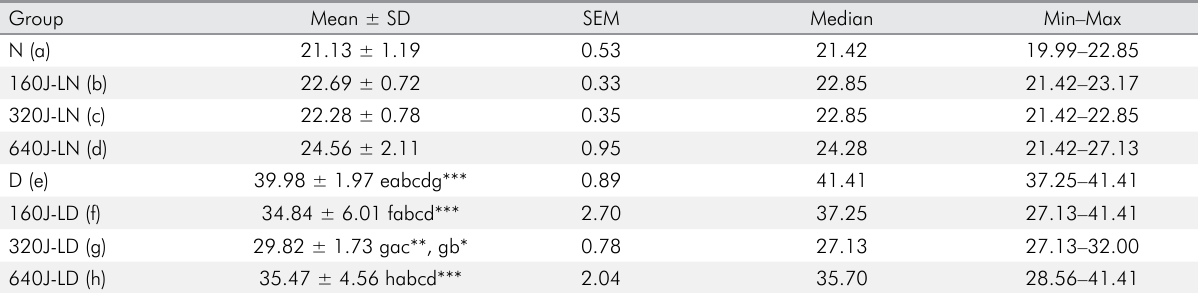
Table 1. Values of the rates of orthodontic tooth movement represented by the interdental distance (pixels) between the cementoenamel junctions of the right mandibular first and second molars (Mean ± SD).